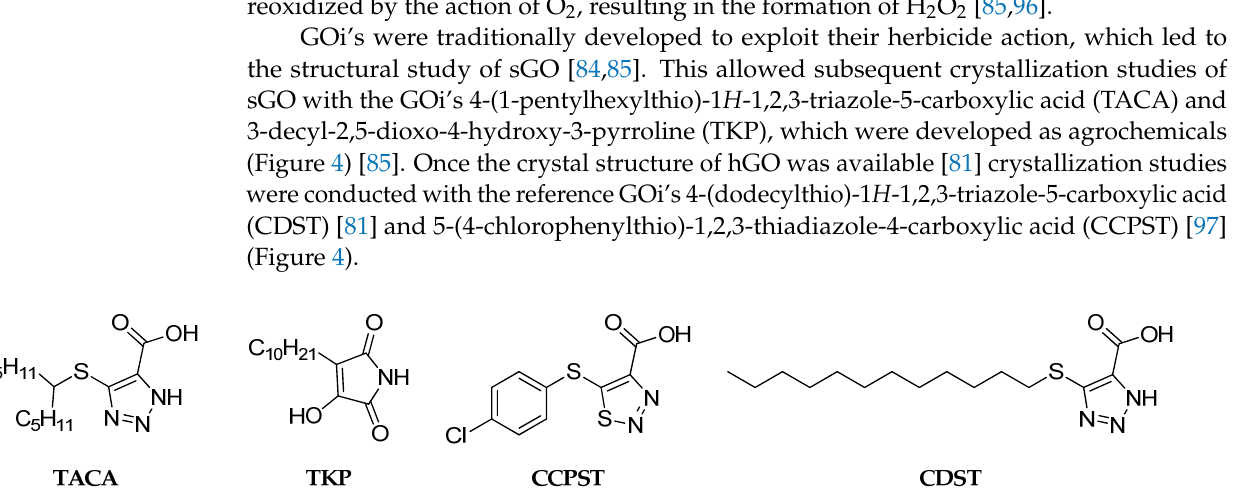
Figure 4. Structure of the known GOi´s TACA, TKP, CCPST and CDST. Two binding regions can be distinguished for GOi´s. According to crystallographic data [81,97], the carboxyl groups of CDST and CCPST mimic glyoxylate interactions at the active site of hGO, interacting with Arg167, Arg263, and Tyr26. Their N3 atoms located at the heterocyclic rings interact with His260 overlaying with the keto group of glyoxylate. However, given that the thiadiazol ring of CCPST does not carry a proton, the interaction of this molecule would require protonation of His260, and this would contribute to the weaker binding of CCPST compared to CDST [98]. Additionally, hydrogen bonds to Tyr132 are also established through the N2 atoms of CCPST and CDST [98]. This group